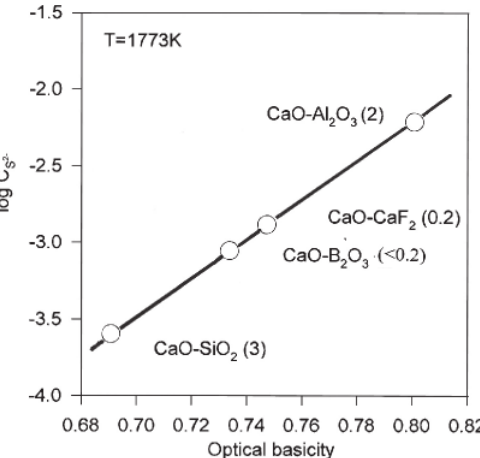
Fig. 2: Sulphide capacity of CaO-saturated binary slags with various secondary components. (The number shown within each bracket represents the viscosity of the slag in 10 − 1 Pa.s at 1773